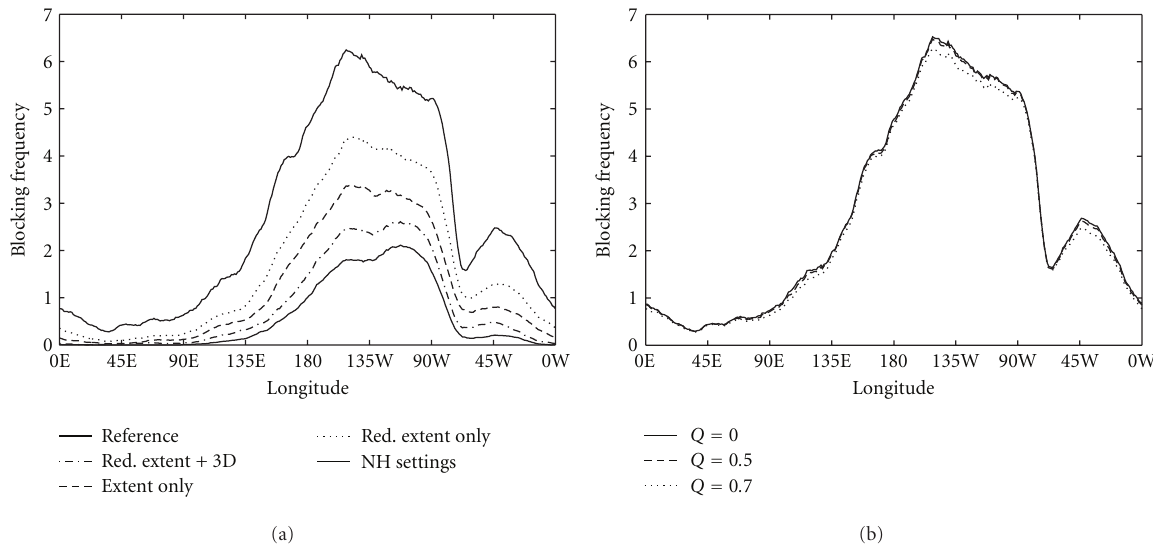
Figure 11: Southern Hemisphere blocking frequency: (a) for the reference setup (no filtering, solid, uppermost curve), NH settings (solid, lowermost curve), persistence filter disabled (dashed), extent filter reduced to 15 . 75 ◦ (dash-dotted), persistence filter disabled and extent filter width 15 . 75 ◦ (dotted) and (b) with quantile filters settings o ff (solid). Q = 0 . 5 (dashed), and Q = 0 . 7 (dotted).